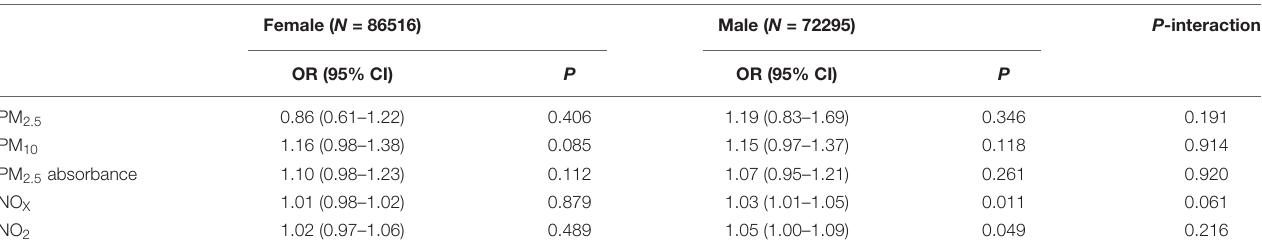
TABLE 5 | Associations of air pollution and hearing impairment in subgroups stratified by gender. Female ( N = 86516) Male ( N = 72295) P